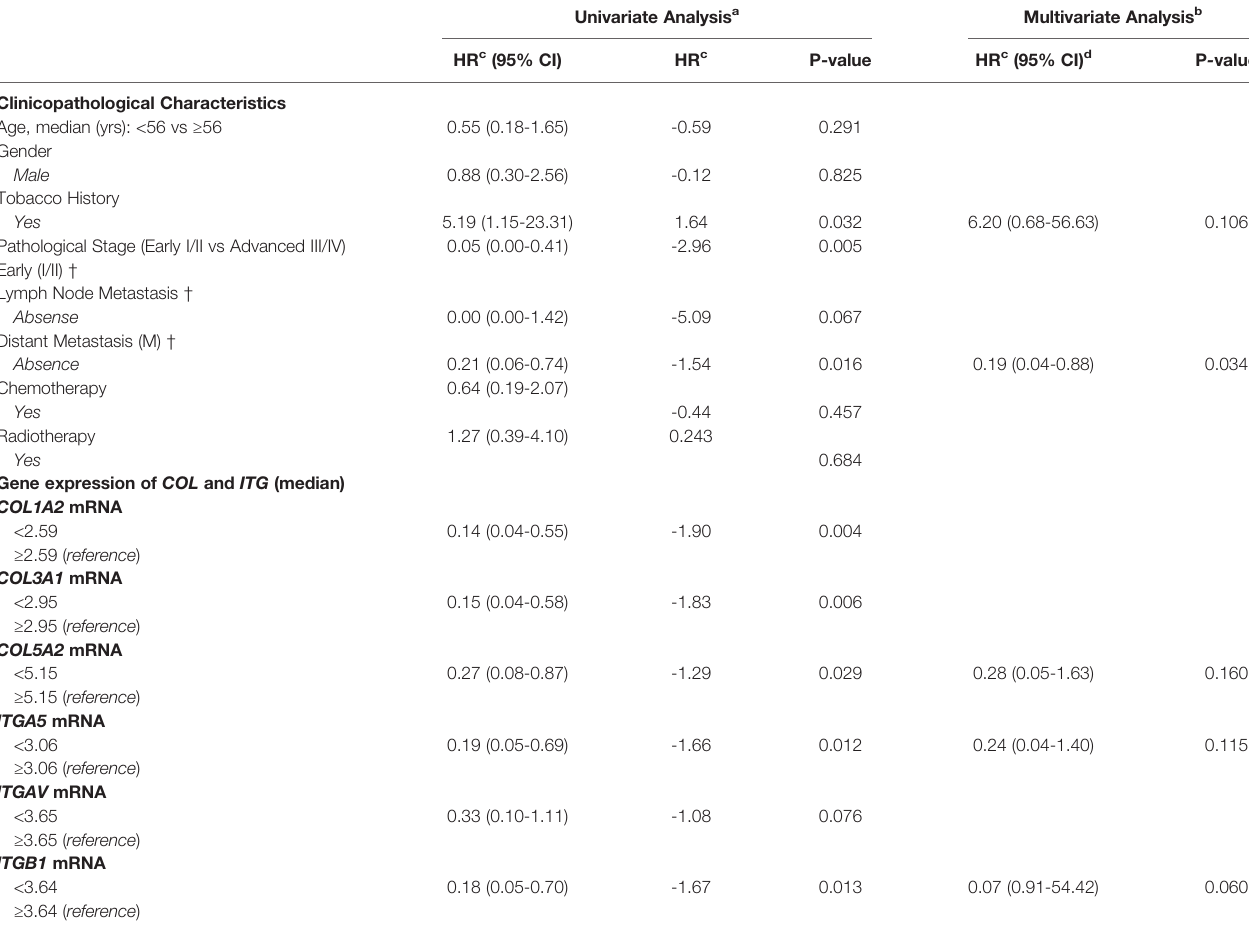
TABLE 5 | Variables associated with overall survival of patients diagnosed with